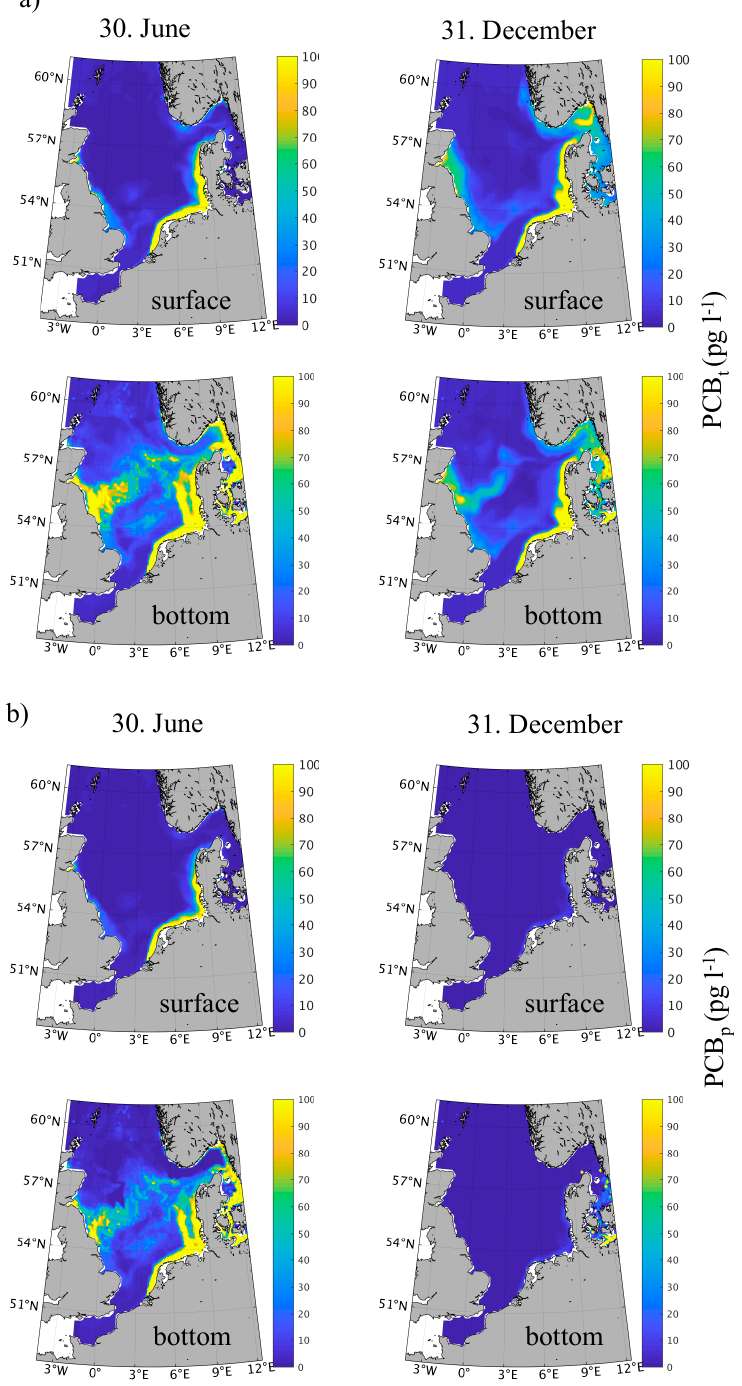
Figure 6. Distributions of total polychlorinated biphenyls (PCB t ) ( a ) and particulate PCBs (PCB p ) ( b ) at the surface and at the bottom in June and December 2006.